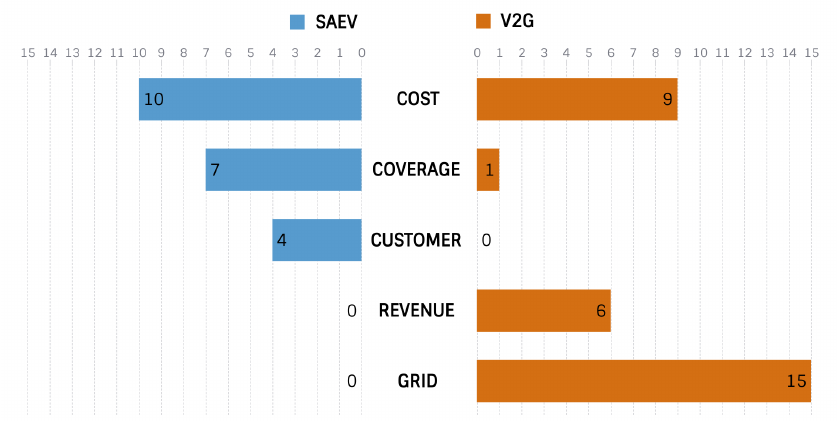
Figure 7. Objective functions used in the reviewed